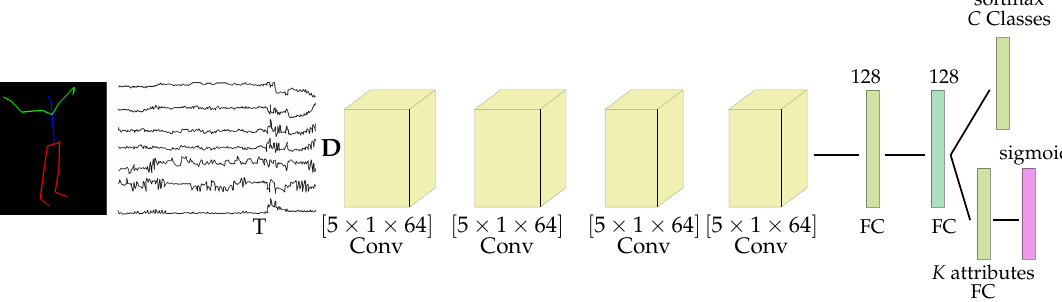
Figure 12. The Temporal Convolutional Neural Network (tCNN) architecture contains four convolutional layers of size [ 5 × 1 × 64 ] . According to the classification task, there are two types of last fully-connected layer: a softmax and a